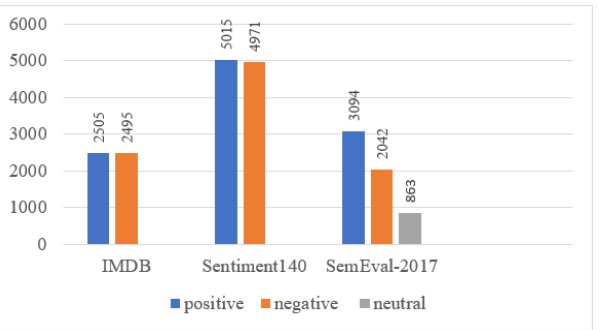
Figure 5. The distribution of texts among positive/negative/neutral sentiment categories in the IMDB, Sentiment 140, and SemEval-2017 datasets.